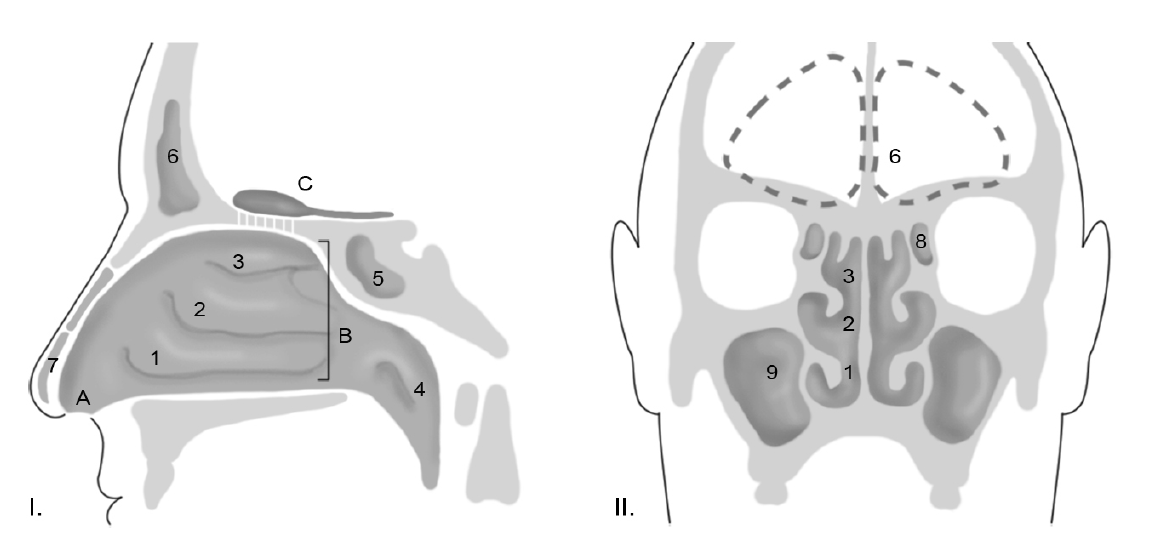
Figure 1. Schematic representation of the human nasal cavity. I. Longitudinal cross-section; II. Transversal cross-section; A. Nasal vestibule; B. Respiratory region; C. Olfactory region; 1. Inferior turbinate; 2. Middle turbinate; 3. Superior turbinate; 4. Nasopharynx; 5. Sphenoid sinus; 6. Frontal sinus; 7. Septal cartilage; 8. Ethmoid sinus; 9. Maxillary